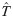
Decisions per bit and timing of decisions.(Left) The number of decisions R required for each bit (Right) The time taken for each decision T^, which remained approximately constant across conditions. Red line shows the minimum fixed delay.